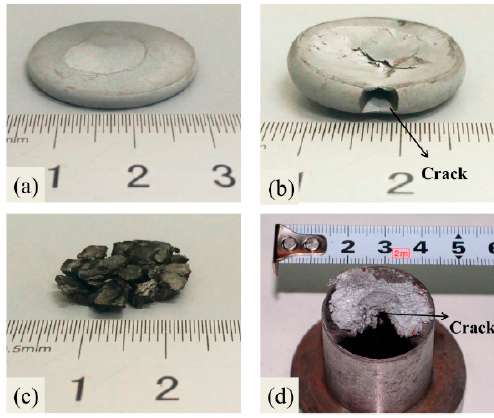
Figure 9. Recovered Al-PTFE samples after compression. ( a ) High crystalline sample after quasi-static compression; ( b ) Low crystalline sample after quasi-static compression; ( c ) Low crystalline sample after SHPB tests; ( d ) High crystalline sample after drop weight tests.